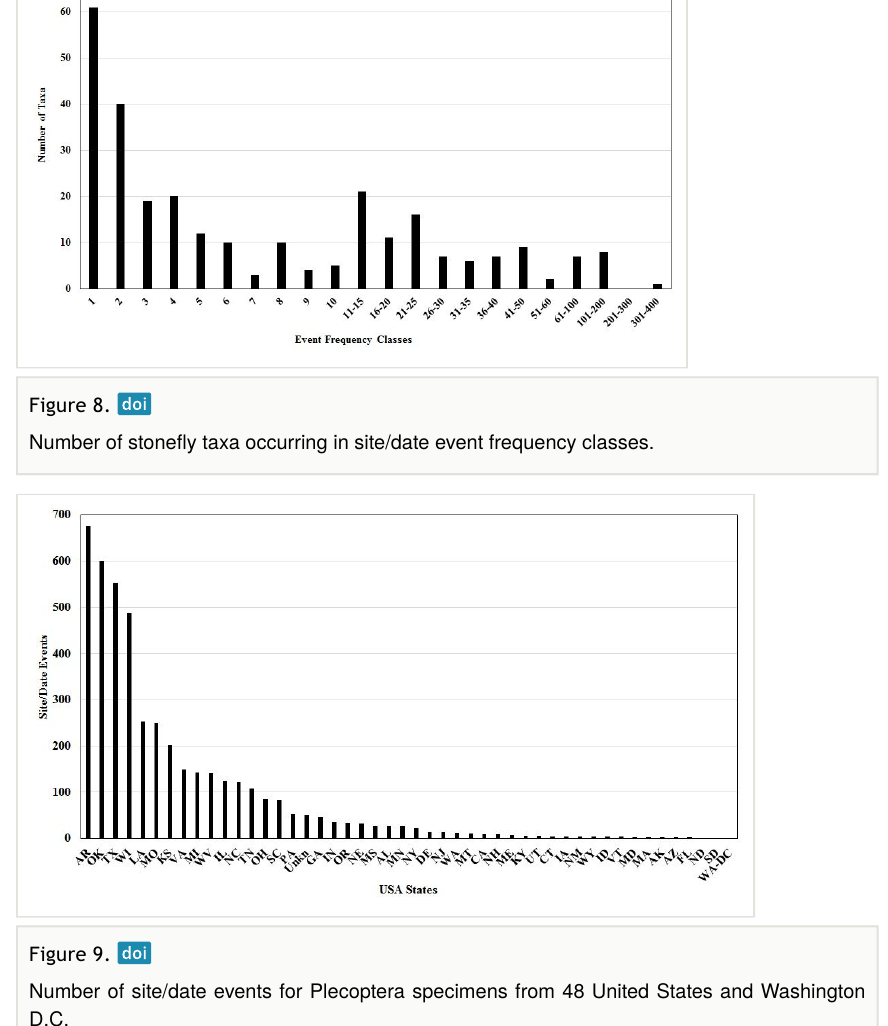
A total of 5,633 of the 5,766 specimen records were georeferenced, the remainder had either confounded label data, were only labeled by undecipherable codes, were labeled by state only, or lacked a locality label. Mapped locations for Canada, Mexico, and the United States demonstrate three clusters of sampled locations (Fig. 10). Cluster 1 involves states within and nearby the Interior Highlands and Gulf Coastal Plains states: Arkansas, Kansas, Louisiana, Missouri, Oklahoma, and Texas. Cluster 2 encompasses the Appalachian Mountains in the east of the continent. A third cluster includes states in the middle and upper Midwest of Illinois, Indiana, Michigan, and Wisconsin.